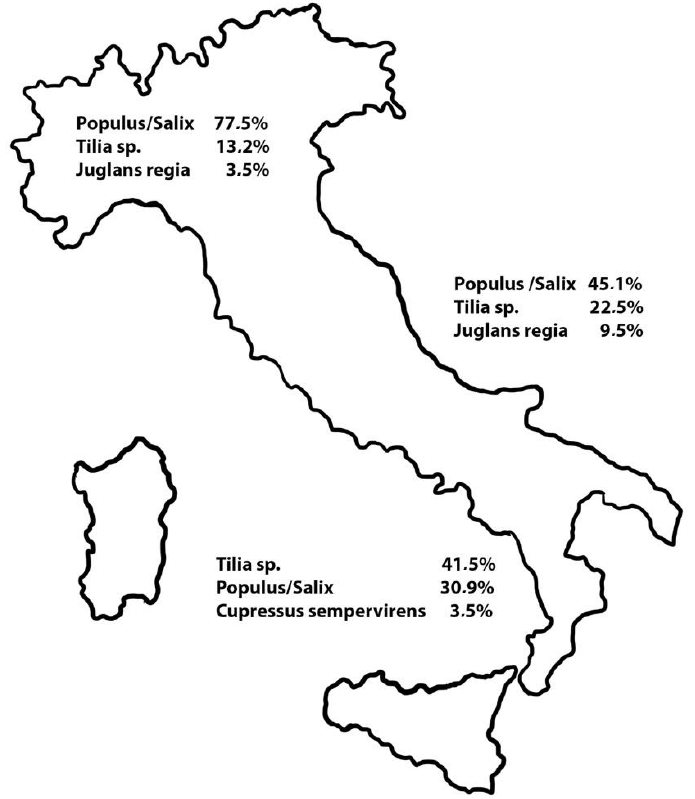
Figure 6. Geographic distribution of the principal timbers for statues in Italy.